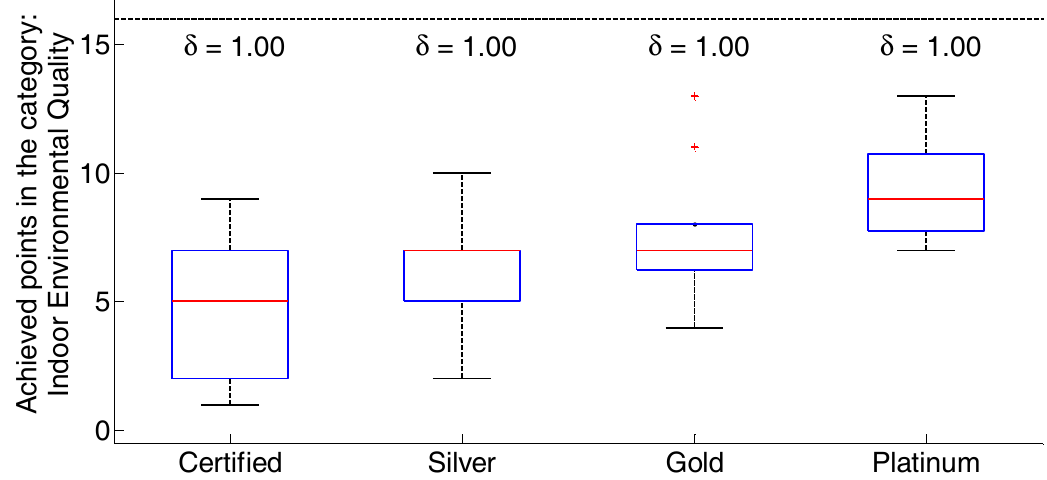
Figure 7. Boxplot results and Cli ff ’s δ e ff ect size between possible and achieved points in the Indoor Environmental Quality (EQ) category. E ff ect size is considered to be: very high if | δ | < 0.147 (bold font), high if 0.147 < | δ | < 0.33 (bold italic font), medium if 0.33 < | δ | < 0.474 (italic font), and low if | δ | ≥ 0.474 (normal font).